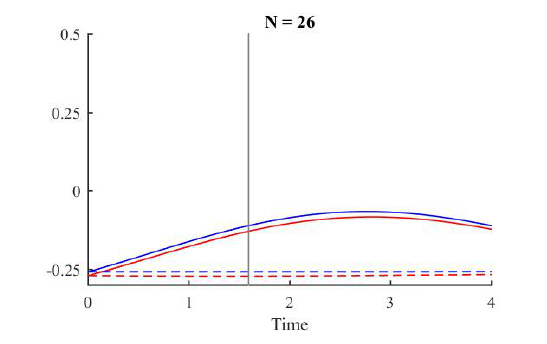
Figure 12 . Comparing the traversable wormhole correlator (4.24) in the thermal state (blue) and typical state (red). The dotted line is the signal without the probe, which is the response one obtains from just the double-trace perturbation and should disappear in the large N limit, in this case a sum over (cid:12)ve pairs of operators was used in the perturbation to limit this e(cid:11)ect. The vertical line denotes the scrambling time and is the time around which the probe is